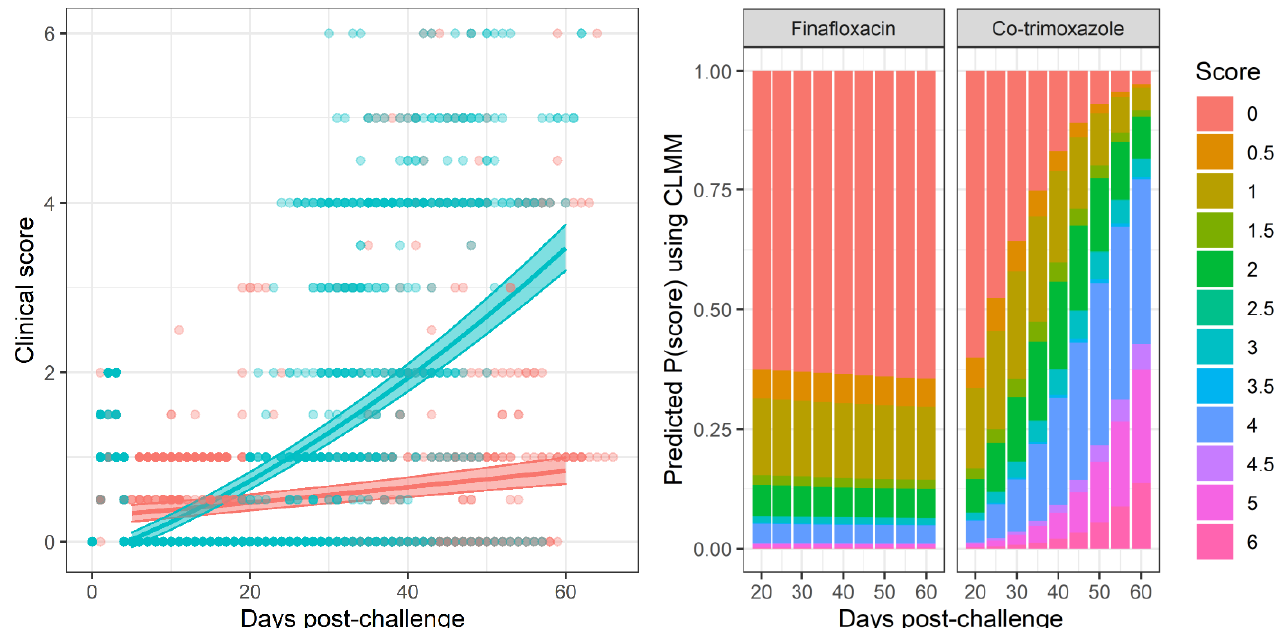
Figure 3. The clinical scores recorded following antibiotic treatment. Mice were infected with a mean retained dose of 142 CFU of B. pseudomallei by the inhalational route and treated with finafloxacin (37.5 mg/kg) every 8 h or co-trimoxazole (78 mg/kg) every 12 h, orally, for 14 days, initiated at 24 h post-challenge. A group of animals were challenged and treated with the vehicle every 8 h. Clinical signs of disease were recorded twice daily throughout the study and are shown in ( left ) using the mixed linear model prediction (i.e., the likelihood of each clinical score as interpreted by the model). The shaded area represents the 95% prediction interval, the dots represent the original data points. Red – mice treated with finafloxacin, blue – mice treated with co-trimoxazole. ( right ) shows the predictions of a cumulative link model in heat map form showing the density of the scores associated with the time point. Supplemental Figures S3 and S4 are diagnostic plots for this analysis.